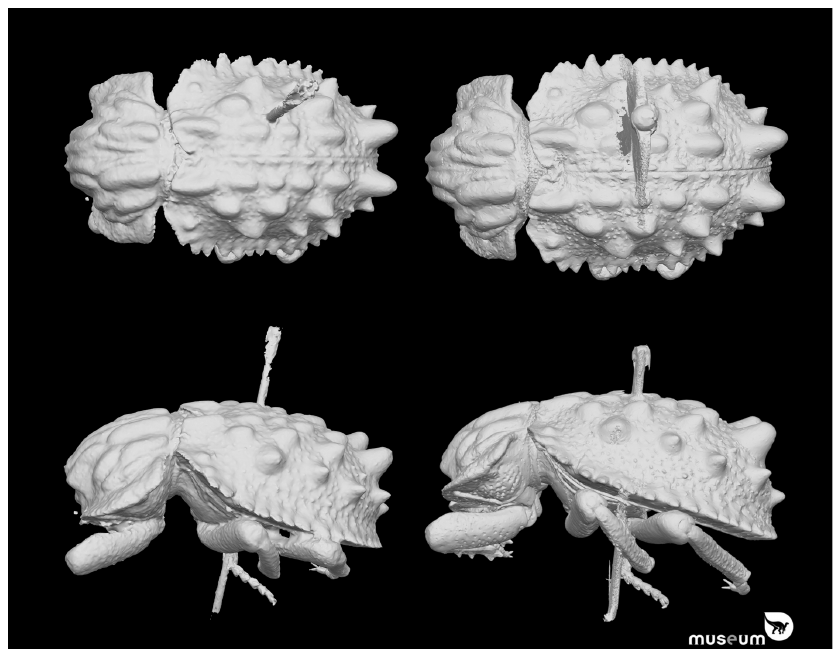
Fig. 6.10. Comparison of the Photogrammetry (left) vs µCT models (right) of the Omorgus beetle. The large difference between them is the less pronounced detail in the photogrammetry model. To fully see the detailed differences, check the models online: